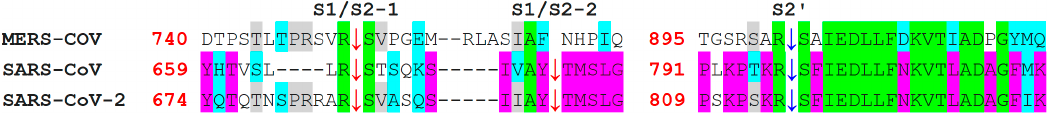
Figure 8. Aligned sequences (performed by use of Clustalw) of furin-like cleavage sites for SARS-CoV-2 that are aligned with those of SARS-CoV and MERS-CoV. Green color indicates positions that have a single, fully conserved residue between the three sequences. Pink indicates amino acids that are conserved between SARS-CoV-2 and SARS-CoV, while grey color indicates those that are conserved between SARS-CoV-2 and MERS-CoV. Cyan indicates conservation between groups that exhibit strongly similar properties and score > 0.5 in the Gonnet PAM 250 matrix [85]. The red arrowheads indicate S1/S2 possible cleavage sites, while the blue arrow shows a S2’ cleavage site. The first S1/S2 site is very similar between SARS-CoV-2 and MERS-CoV, while the second S1/S2 is found only in SARS-CoV and SARS-CoV-2. The S2’ cleavage site in SARS-CoV-2 is similar to that of SARS- CoV.